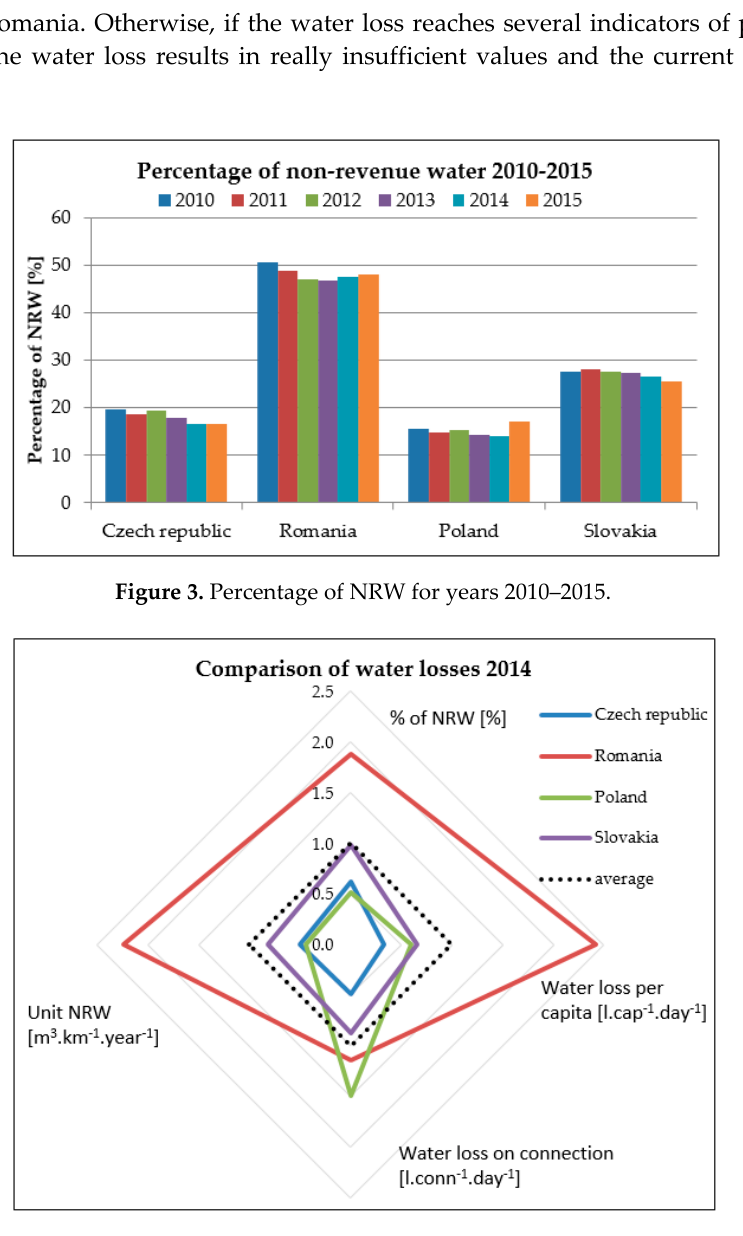
Figure 4. Comparison of water losses for year 2014 through different